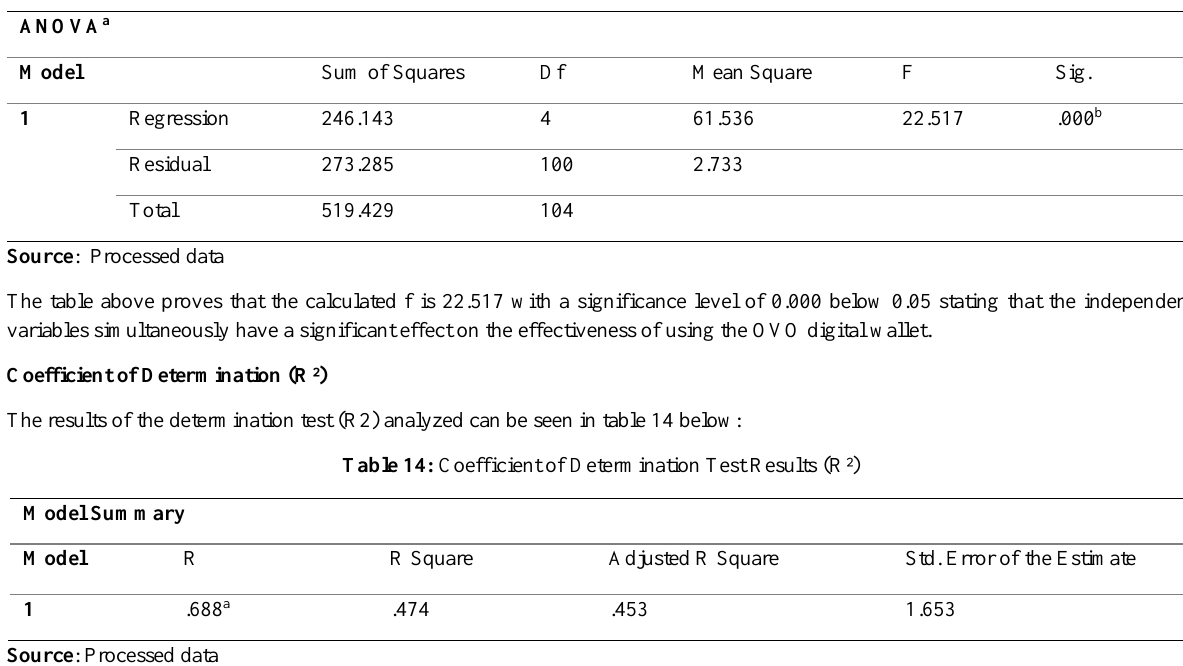
Table 13: F Test